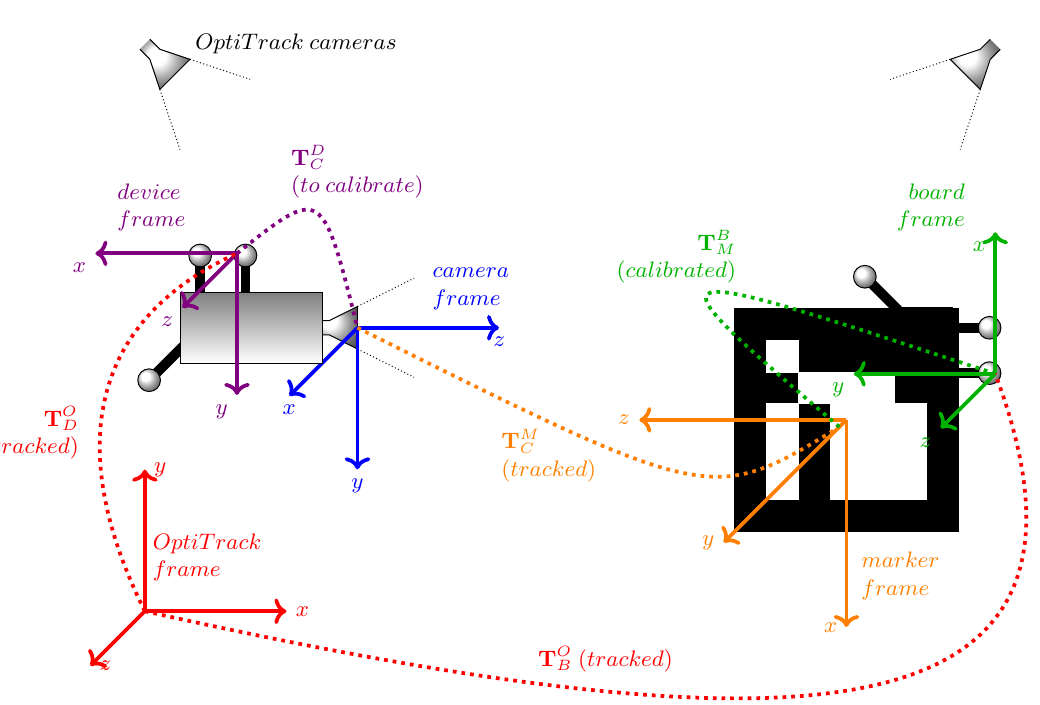
Figure 5. Calibration procedure to determine the pose T D camera device and a marker board are directly tracked with OptiTrack, while the camera pose relative to the marker on the board T M can be tracked by means of marker-based tracking.